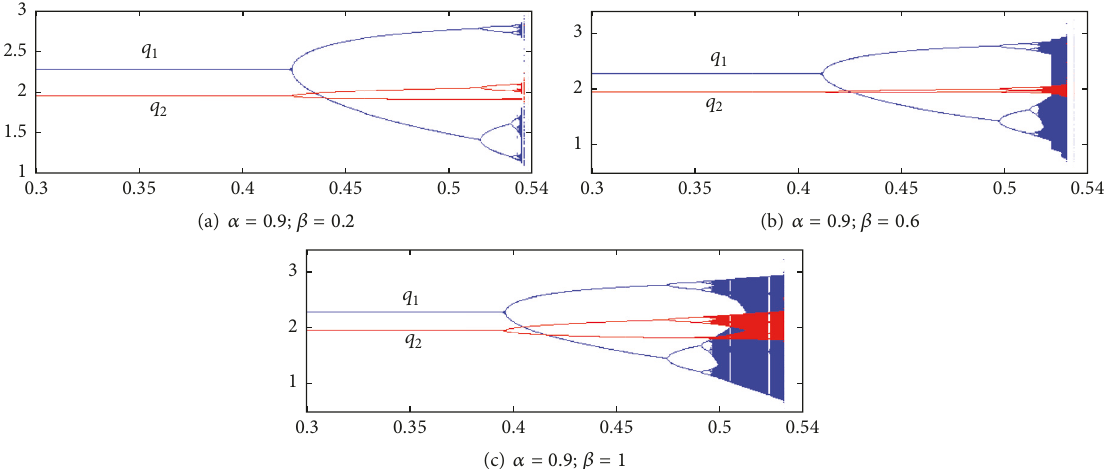
Figure 1: Bifurcation diagrams with respect to the adjustment speed V for the same 𝛼 and different 𝛽 .